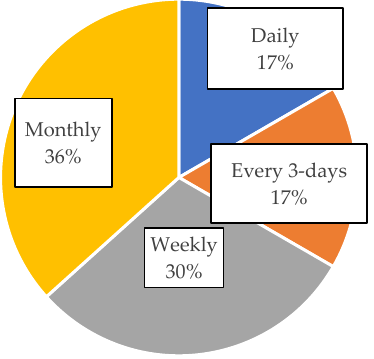
Figure 10. Frequency of C&D waste disposal by the sites.